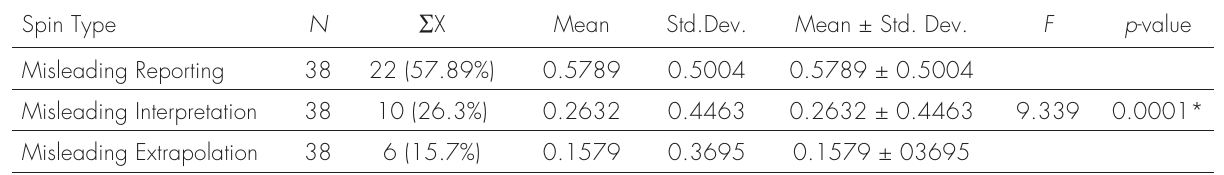
Table IV. Prevalence of different types of